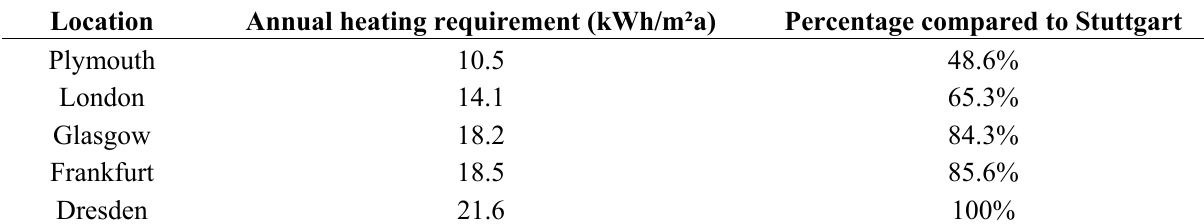
Table 2. Comparison of annual heating requirement (kWh/m²a) of case study building in different